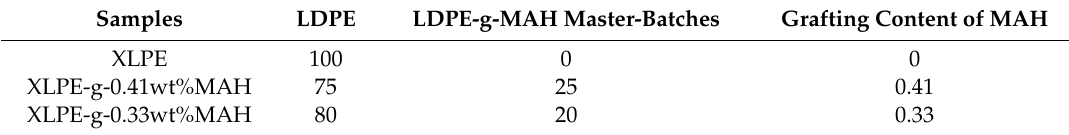
Table 1. Blending components (wt%) for preparing XLPE and XLPE-g-MAH